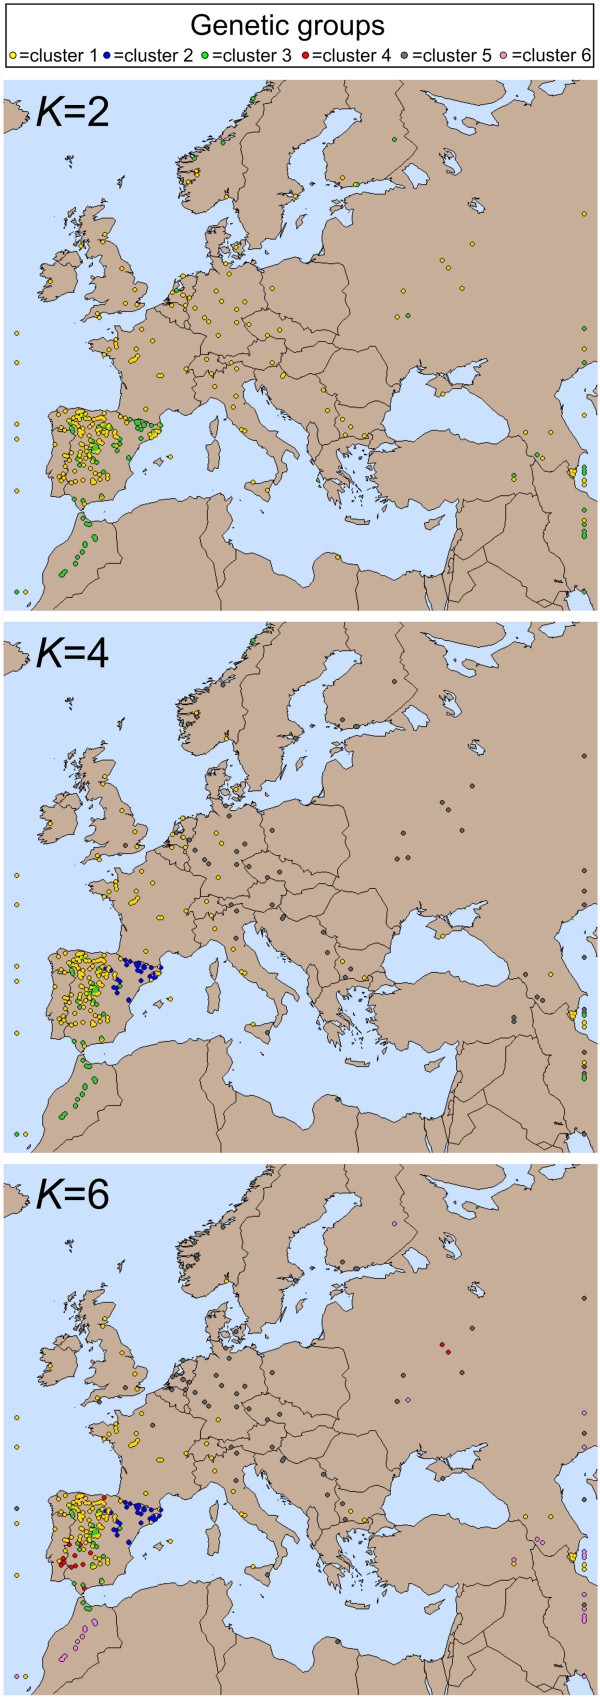
Genetic and geographic structure of A. thaliana at a global scale. Genetic group assignment of accessions is based on majority membership proportions inferred with STRUCTURE, for K = 2, K = 4 and K = 6. Accessions located outside the Eurasian map are shown at their corresponding latitude in the left (American accessions) and right (Asian accessions) edges.